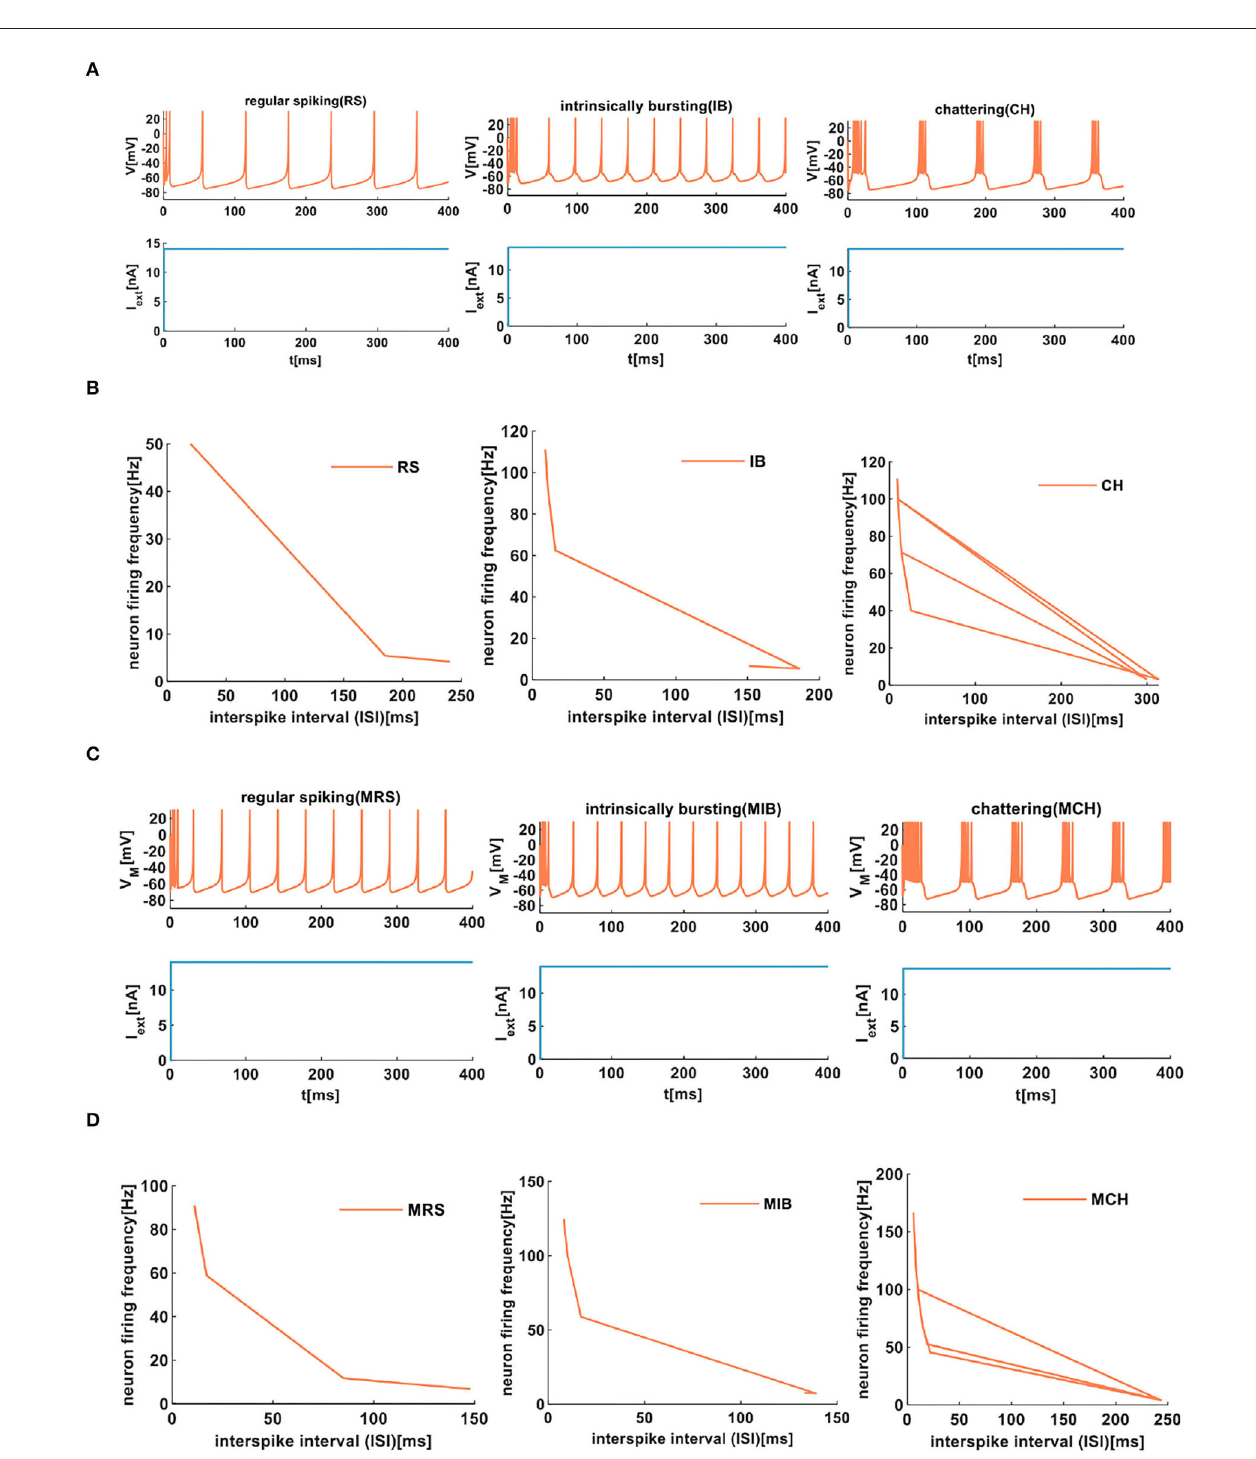
FIGURE 6 | The firing behaviors of excitatory cortical neurons are produced by the IZH spiking model and the MIZH spiking model. (A) The firing patterns of the excitatory cortical neurons for the IZH spiking model (the coral color plot represents the membrane potential, and the light blue plot represents the external stimulus. The values of parameters are a = 0.01, b = 0.2, c = − 65, d = 8, and I ext = 14 nA for the RS neurons; a = 0.01, b = 0.2, c = − 55, d = 4, and I ext = 14 nA for the IB neurons; a = 0.02, b = 0.08, c = − 50, d = 2, and I ext = 14 nA for the CH neurons). (B) The evolution of the neuron firing rate versus the inter-spike interval for the RS, IB, and CH neurons of the IZH spiking model. (C) The firing patterns of the excitatory cortical neurons for the MIZH spiking model (the values of parameters are a = 0.08, c = − 65, d = 4, and I ext = 14 nA for the MRS neurons; a = 0.1, c = − 55, d = 4, and I ext = 14 nA for the MIB neurons; a = 0.05, c = − 50, d = 2, and I ext = 14 nA for the MCH neurons). (D) The evolution of the neuron firing rate versus the inter-spike interval for the MRS, MIB, and MCH neurons of the MIZH spiking model.